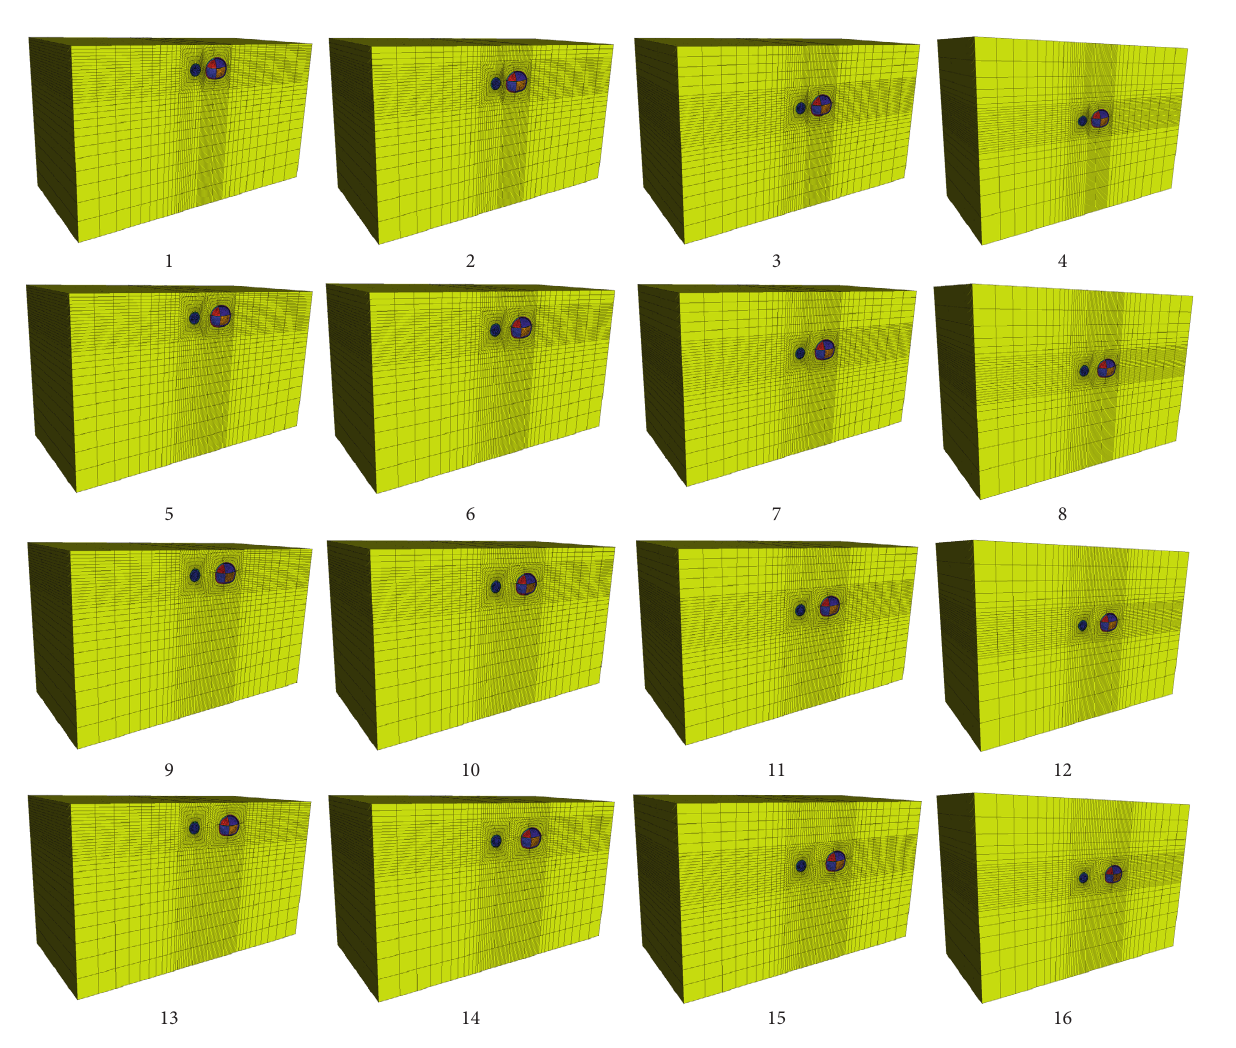
Figure 27: Numerical calculation model of 16 conditions.